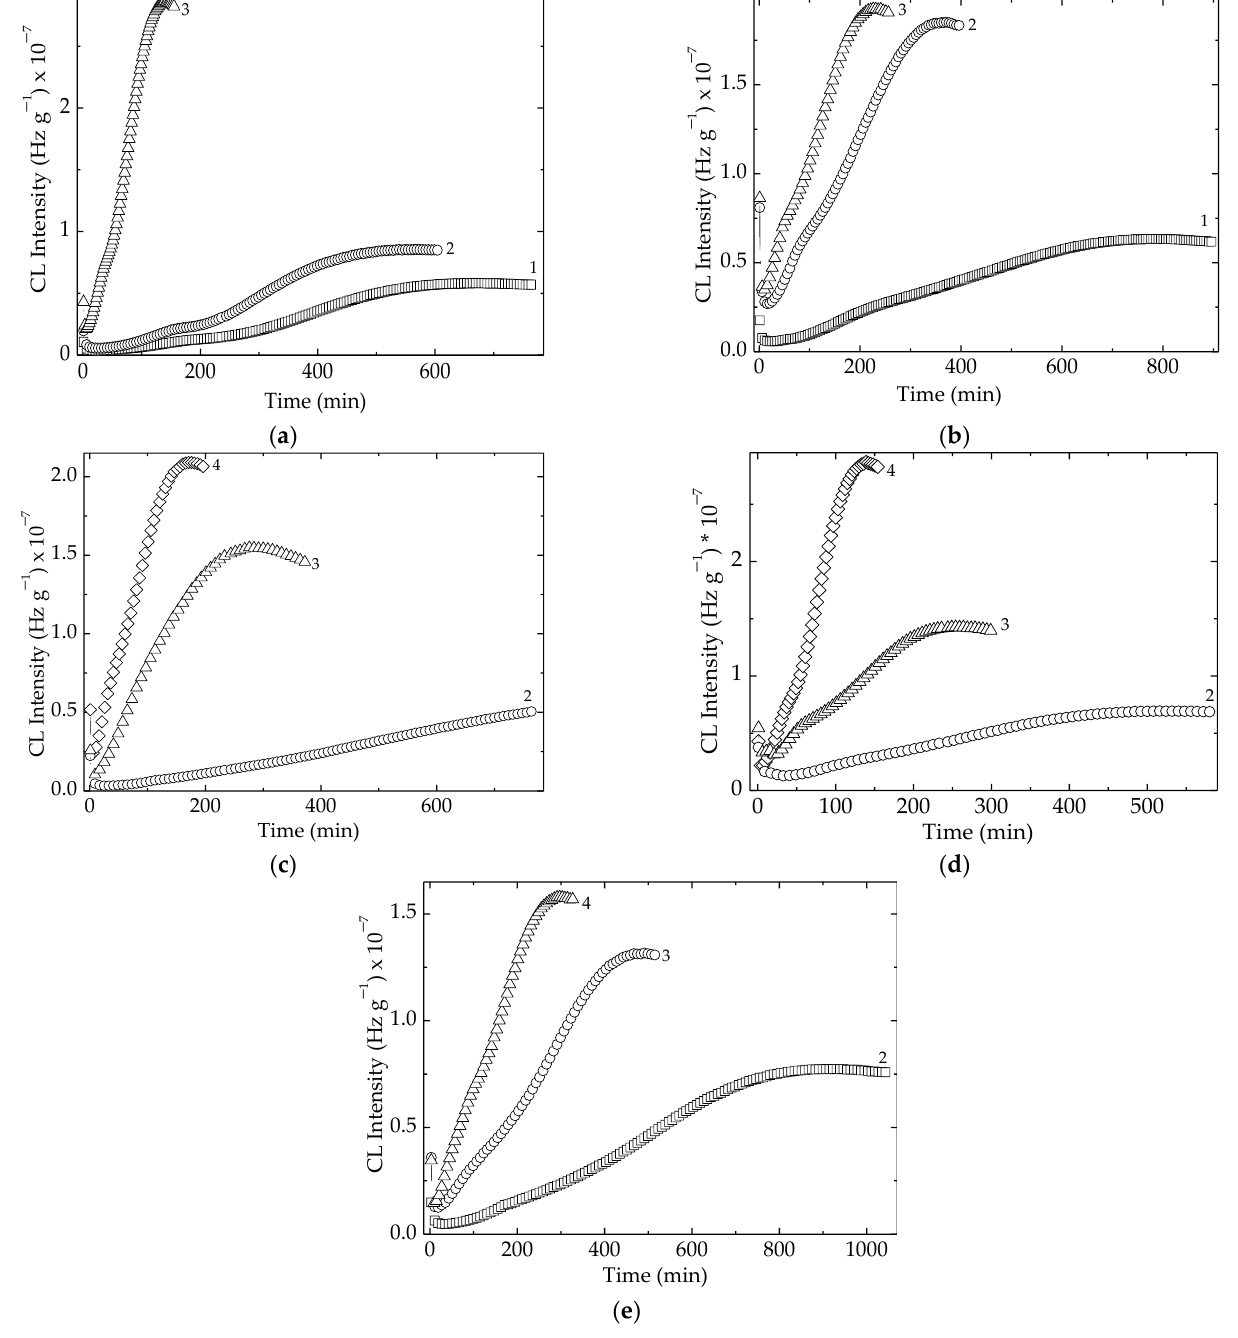
Figure 4. Isothermal CL spectra recorded for all the investigated samples. Temperatures: (1) 160 °C, (2) 170 °C, (3) 180 °C, (4) 190 °C. Irradiation dose: 50 kGy. ( a ) LDPE/UHMWPE; ( b ) LDPE/HAp; ( c ) LDPE/HAp/RM; ( d ) LDPE/UHMWPE/HAp; ( e ) LDPE/UHMWPE/HAp/RM.